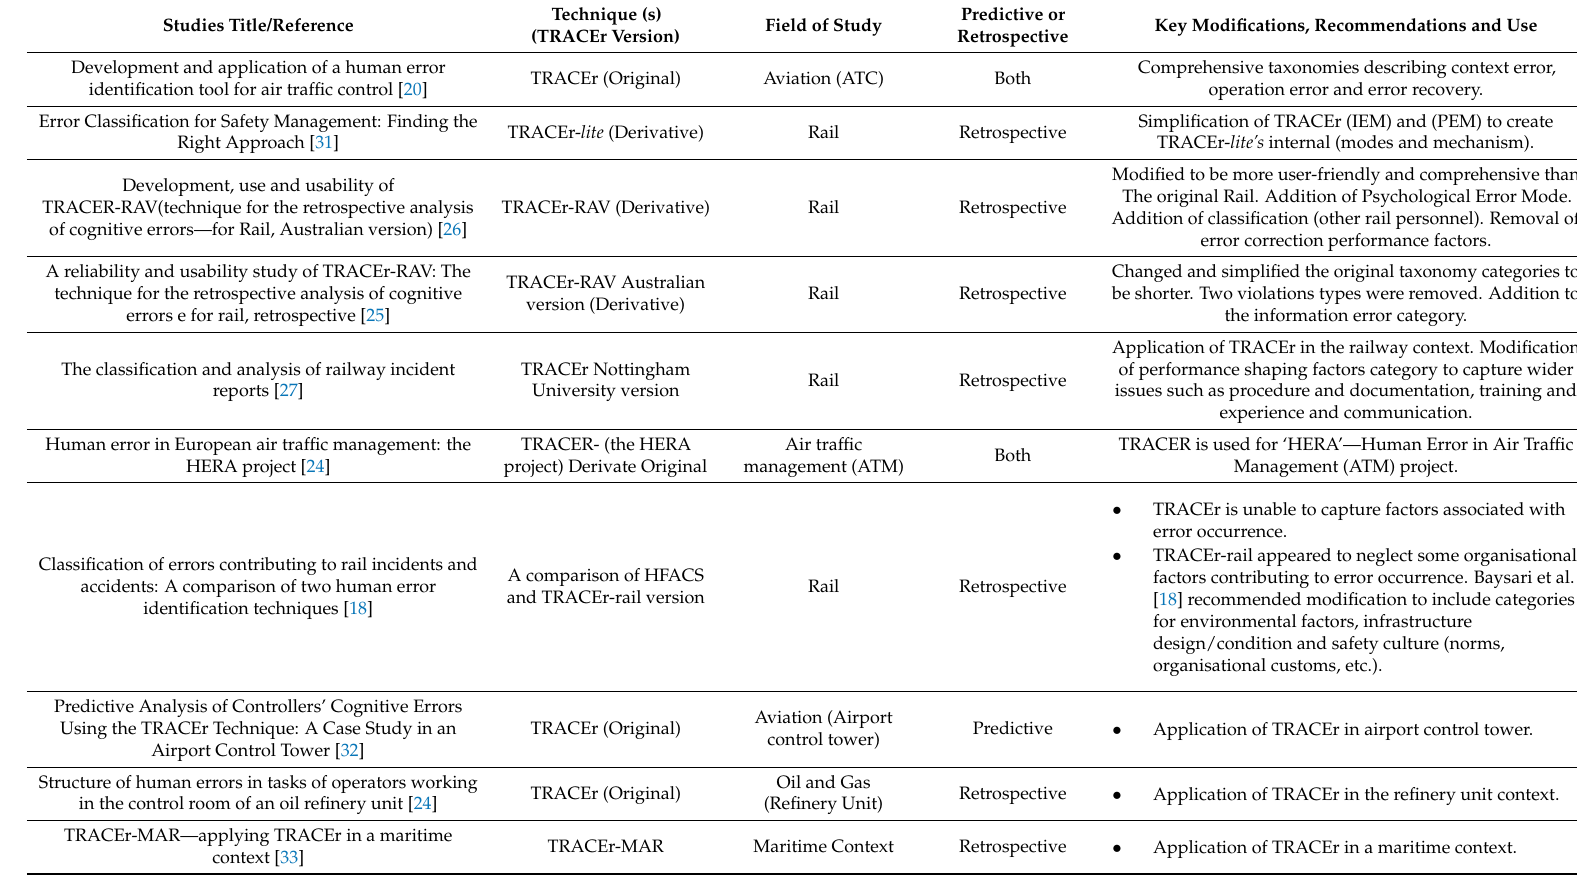
Table 3. List of TRACEr modifications and field of study reviewed in the development of TRACEr for the Oil and Gas Industry